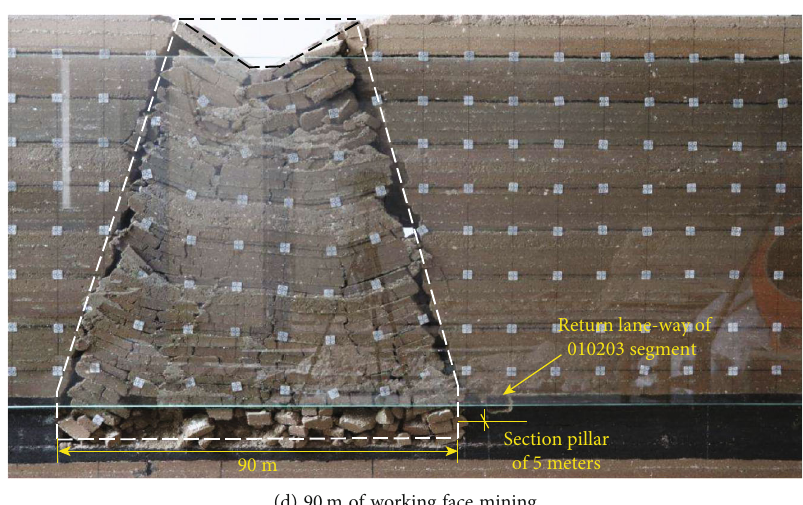
Figure 9: Evolution of overburden structure in 010202